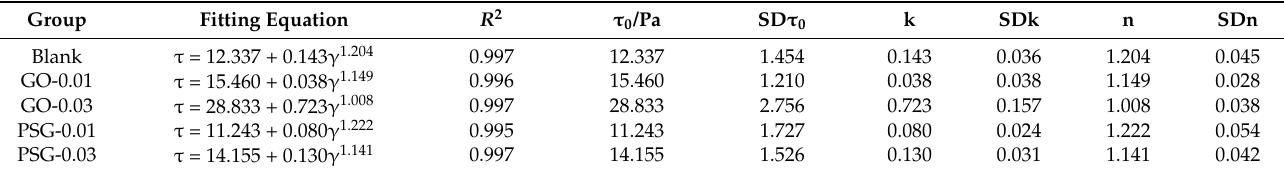
Table 6. Fitting results of H–B model